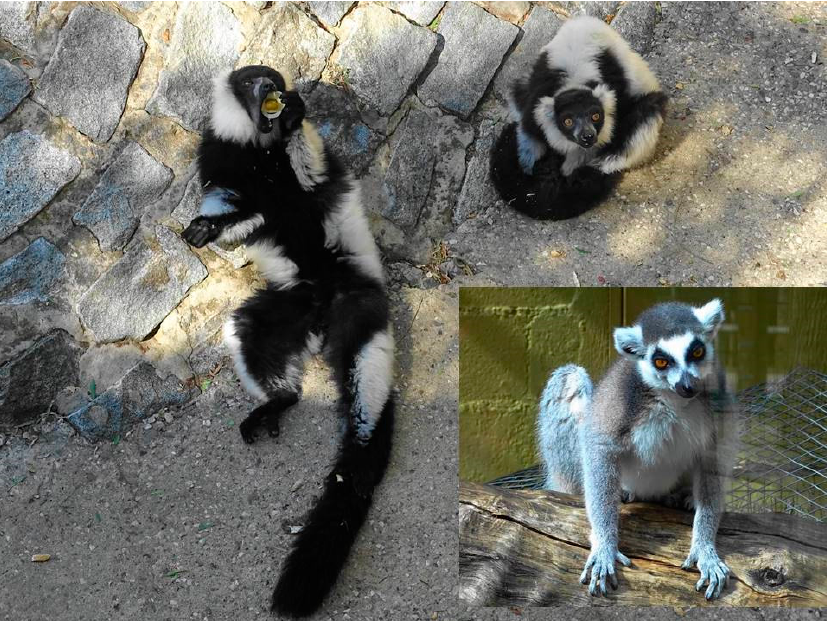
Figure 2. Two black-and-white ruffed lemurs Varecia variegata , one showing the black ventral area including the insides of the legs ( left ), and the other one showing the white dorsal area ( top - right ). These lemurs are arboreal, diurnal, and live in the rainforests of eastern Madagascar. In the lower right, a ring-tailed lemur Lemur catta showing a typical countershaded coloration, darker on top and white below. The ring-tailed lemur is the most terrestrial of all lemurs. It lives in forests and scrubland in southern Madagascar. Photographs taken at Zoobotánico Jerez (Spain) by Juan J. Negro. The economy of pigments could be in fact the universal law sought after by Thayer and subsequent followers. Many mammals, and the majority of quadrupeds, place less pigment in ventral areas, including the inside of the legs. This is so both in wild species and in domesticated breeds. Could this always be for camouflage? We doubt it. Even humans have less pigment in the